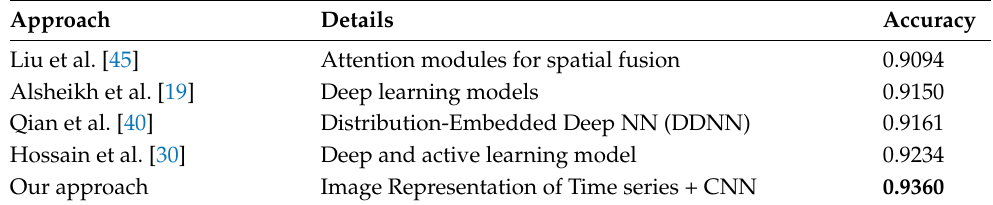
Table 7. Comparison considering Daphnet dataset.